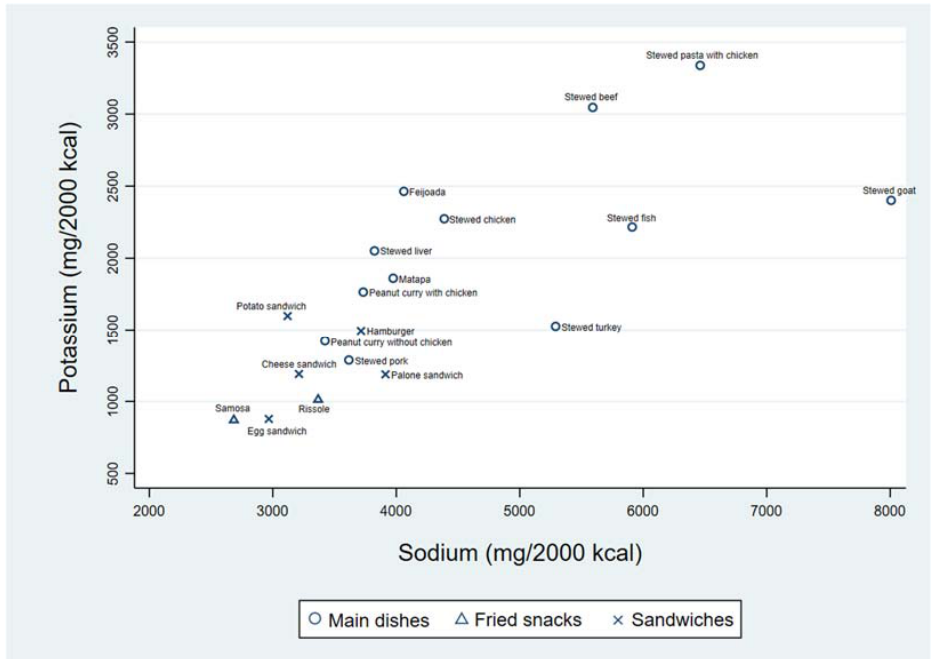
Figure 3. Mean contents of sodium and potassium (mg/2000 kcal) for each of the defined food items ( n = 19). Feijoada is a traditional main dish which consists of Stewed beans with beef and/or pork; Matapa is a traditional main dish made with peanuts, coconut, cassava leaves and shrimps. Samosa is a crispy fried triangular pastry with a savoury filling that may be made with different ingredients such as minced meat, spiced chicken, vegetables or fish with onions, garlic and/or other spices.